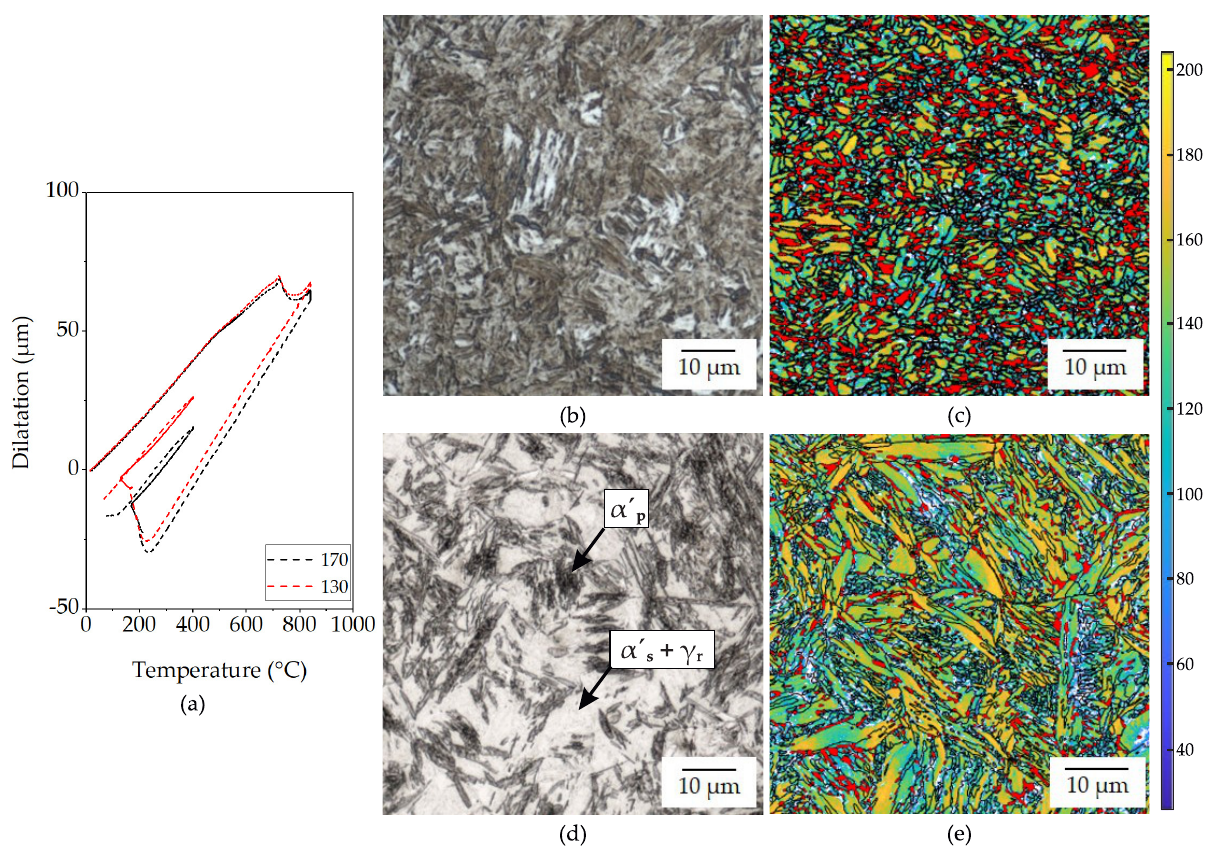
Figure 7. ( a ) Dilatation curves for QP170_60 and QP130_60; ( b ) light optical micrograph of QP130_60; ( c ) combination of EBSD phase map (fcc = red) and IQ map of QP130_60; ( d ) light optical micrograph of QP170_60 showing primary (dark) and secondary martensite (bright); ( e ) combination of EBSD phase map (fcc = red) and IQ map of QP170_60.